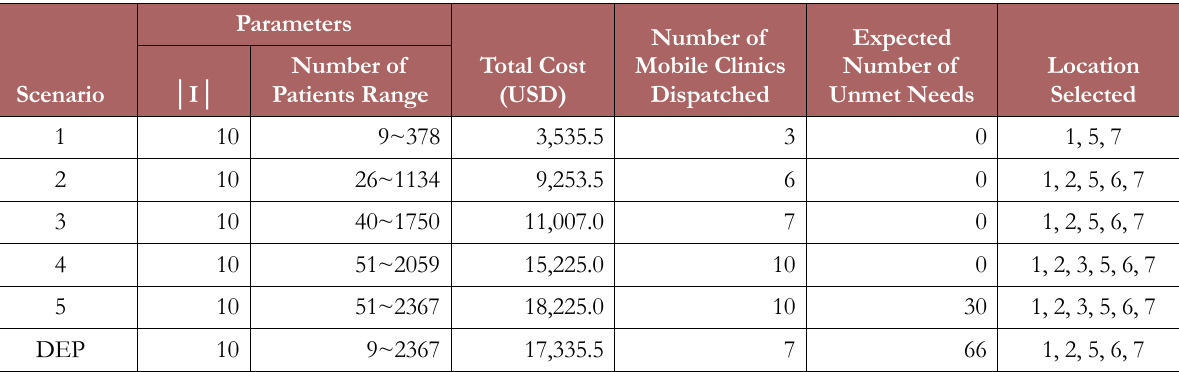
Table 3. Computational Results for Jakarta Flood Data